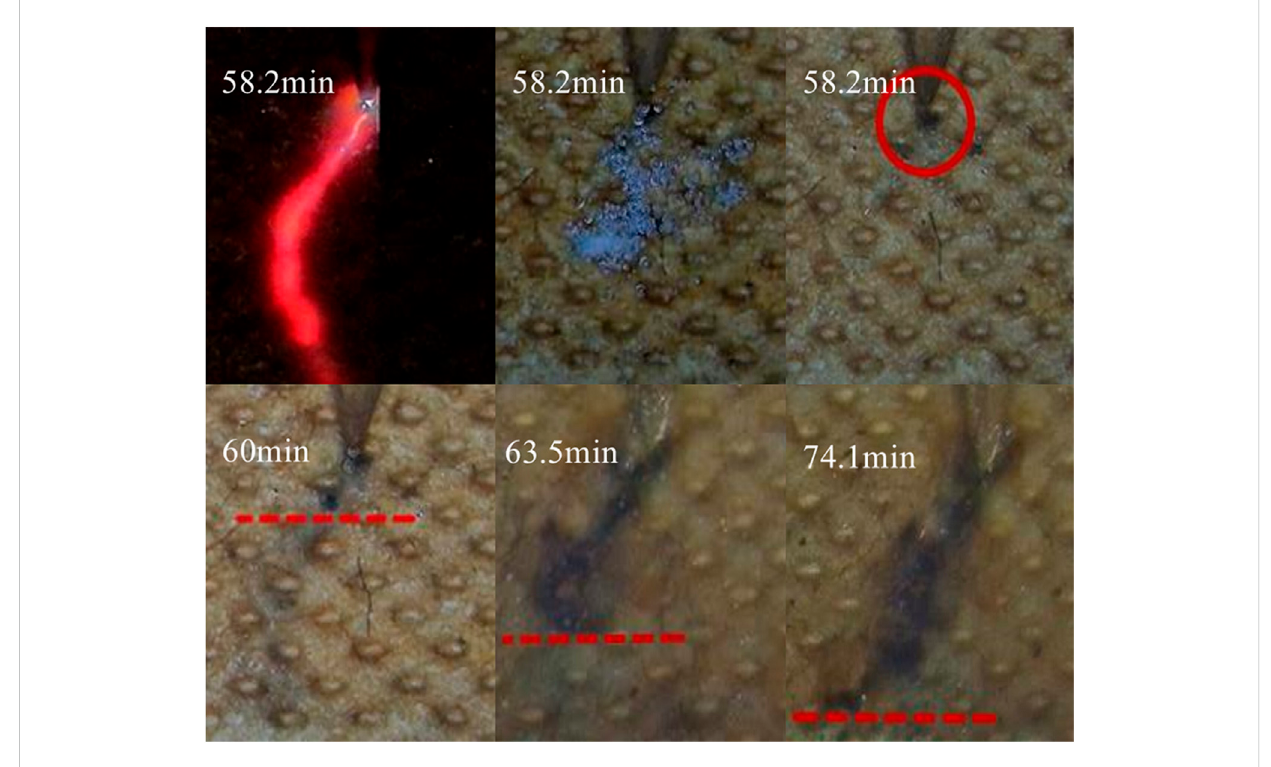
FIGURE 6 Carbon trace development process on cardboard surface in pure insulating oil.